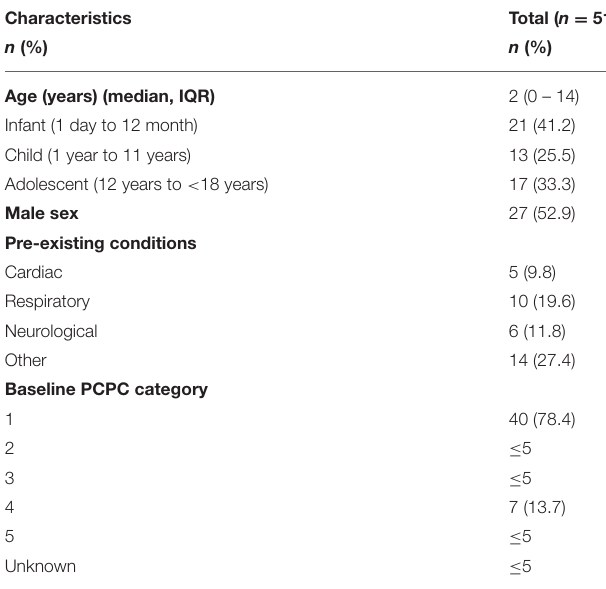
TABLE 1 | Patient